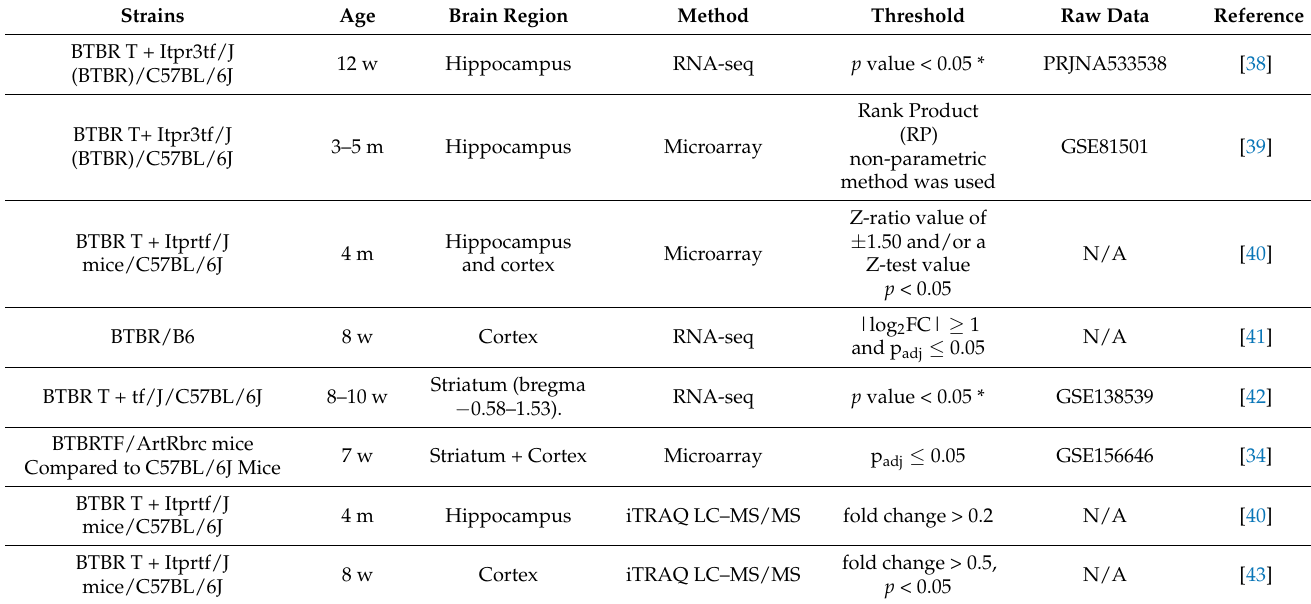
Table 1. The transcriptomic and proteomic studies on BTBR mice included in the